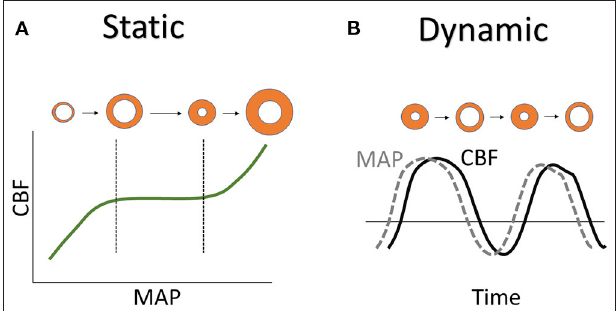
FIGURE 2 | Static vs. dynamic autoregulation. (A) Static autoregulation is shown using Lassen autoregulatory curve with orange circles representing blood vessels state of vasodilation near the LLA and vasoconstriction near the ULA. (B) Dynamic autoregulation is shown by the MAP and CBF curves with orange circles representing the vasodilation and vasoconstriction of blood vessels with time. CBF, cerebral blood flow; LLA, lower limit of autoregulation; MAP, mean arterial pressure; ULA, upper limit of